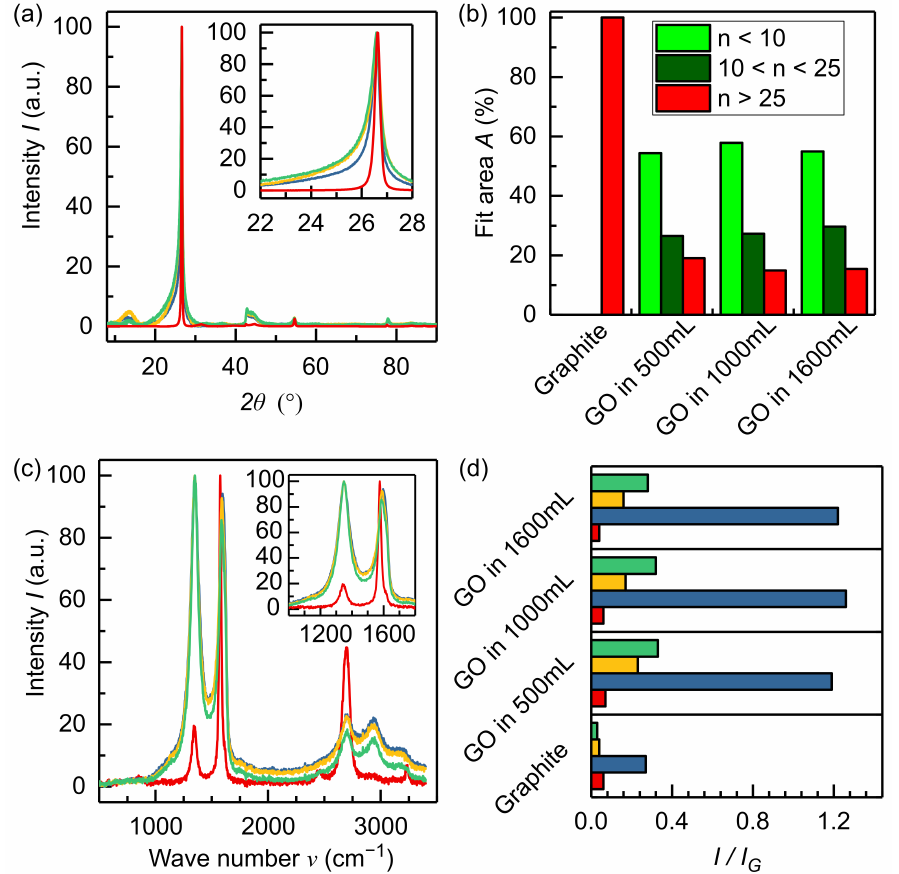
Figure 2. ( a ) XRD diffractogram of graphite educt (red) and electrochemically produced graphene oxide powders at different up-scaling stages (500 mL reactor (blue), 1000 mL reactor (yellow) and 1600 mL reactor (green)); ( b ) distribution of layer numbers calculated from the (002) reflex of the respective XRD measurement; ( c ) Raman spectra of graphite educt (red) and graphene oxide powders at different up-scaling stages (500 mL reactor (blue), 1000 mL reactor (yellow) and 1600 mL reactor (green)); ( d ) calculated Intensity ratio to the G band I / I G of first-order defect bands (D* red, D blue, D” yellow, D’